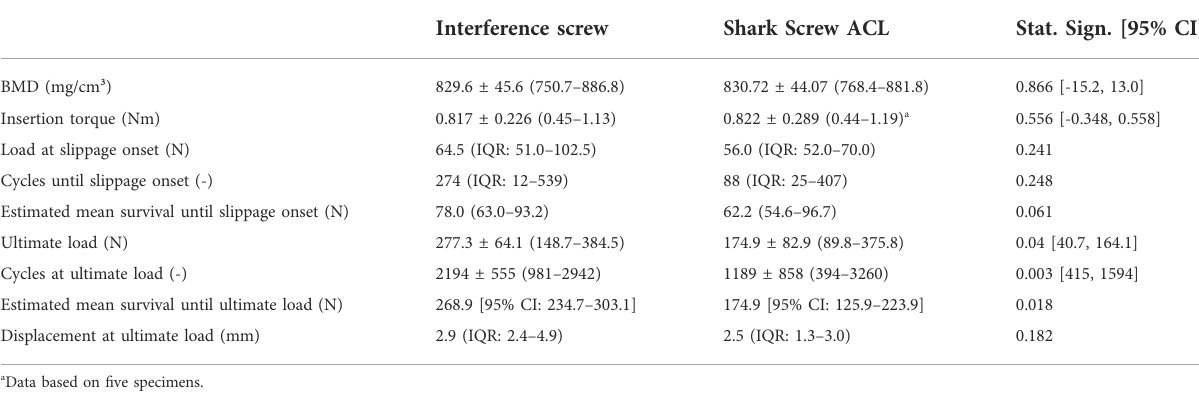
TABLE 1 Results of biomechanical tests.